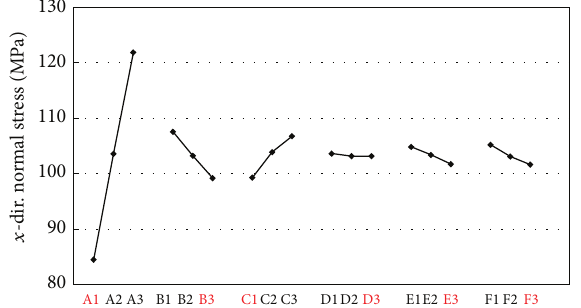
Figure 16: Effect of control factors on the bending stress of the ITO/ PR conductive layer.